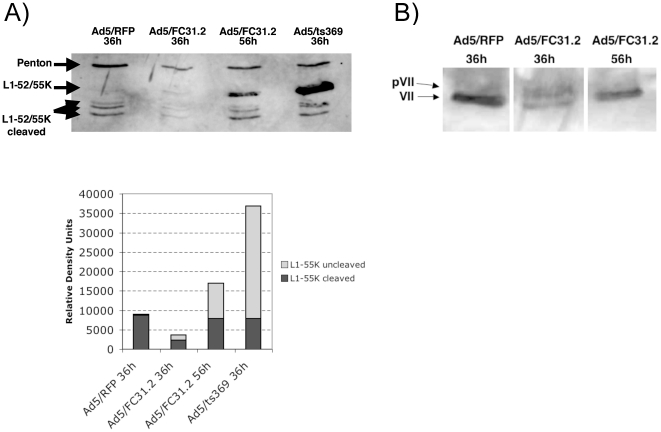
Analysis of L1-52/55K and pVII proteins of
attB-adenovirus.(A) Western Blot analysis of penton base (control for protein content)
and L1-52/55K viral proteins from CsCl gradients of Ad5/RFP and
Ad5/ts369 at 36 hpi and attB-Ad at 36 and 56 hpi
(cleaved and uncleaved L1-52/55K protein are indicated by arrows).
Densitometric analysis of the Western-blot for the L1-52/55K cleaved and
uncleaved proteins after normalization to penton base. (B) Western blot
analysis of adenoviral protein pVII from CsCl gradients of Ad5/RFP at 36
hpi and attB-Ad at 36 and 56 hpi.